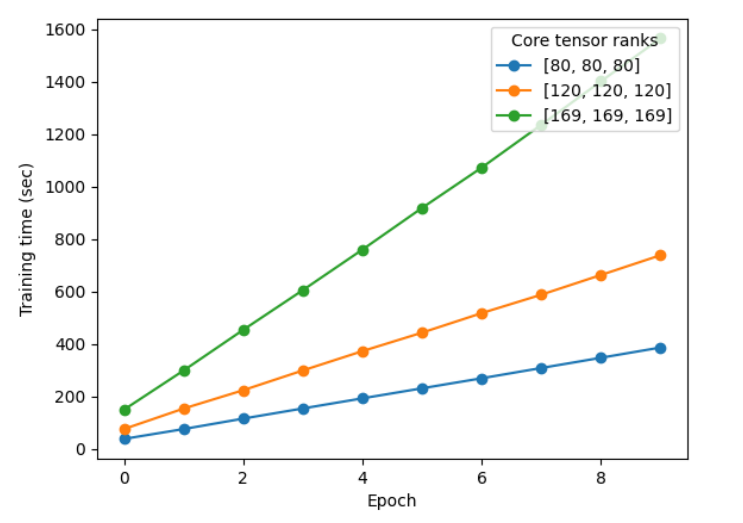
Figure 12. Gated RBM training time comparison with different core tensor